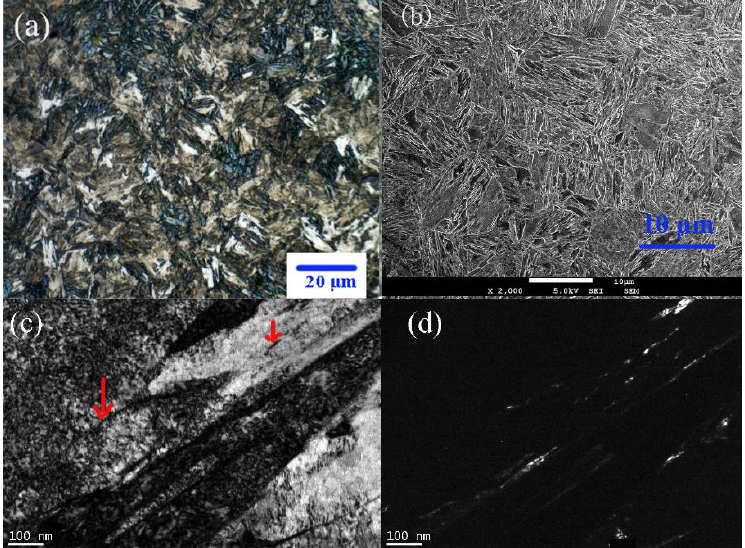
Figure 2. Optical micrograph ( a ), secondary electron micrograph ( b ), and transmission electron micrograph ( c , d ) of the water-quenched steel after austenization.